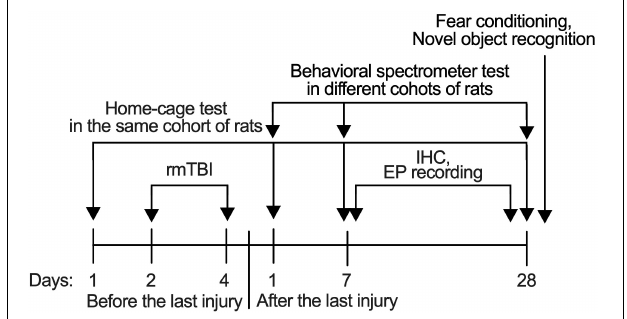
FIGURE 1 | Timeline of procedures. All behavioral tests except home-cage scanning test were performed with different set of rats in different time-points to avoid the influence from another